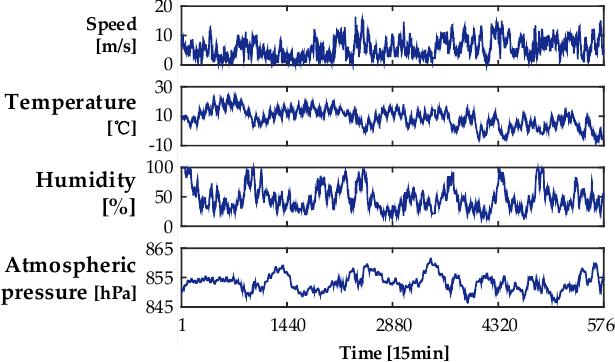
Figure 4. Original data of wind speed, temperature, humidity and atmospheric pressure.